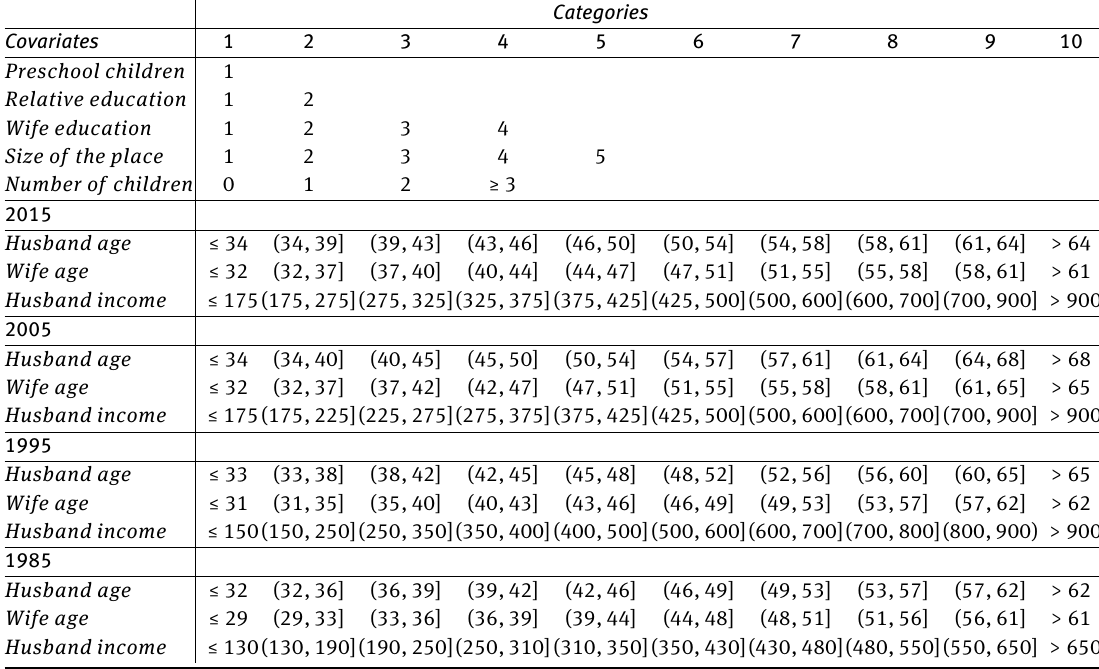
Table 2: Classes and categories for the continuous and categorical covariates defined according to the survey